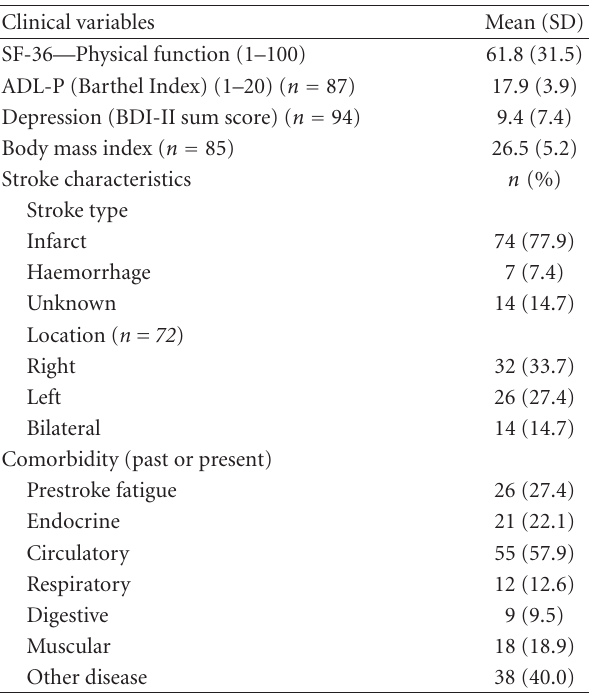
Table 2: Clinical characteristics at baseline of the study sample ( N =